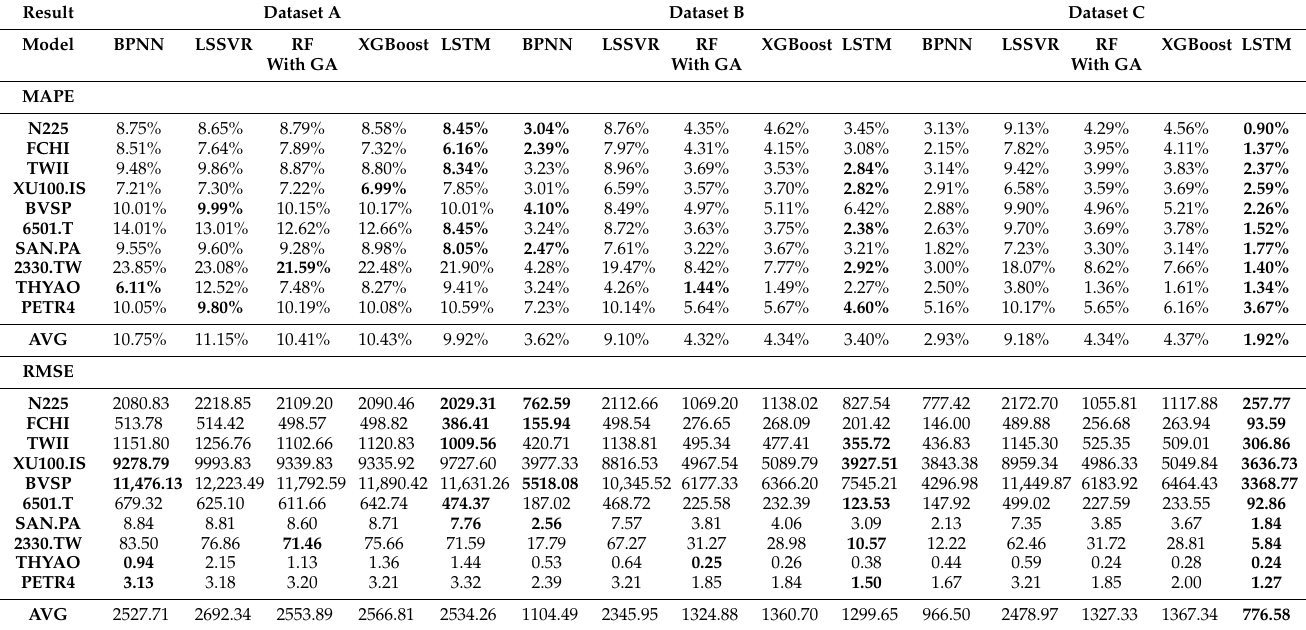
Table 10. The Wilcoxon signed–rank test of LSTMGA models in terms of dataset C to dataset A and dataset C to dataset B.